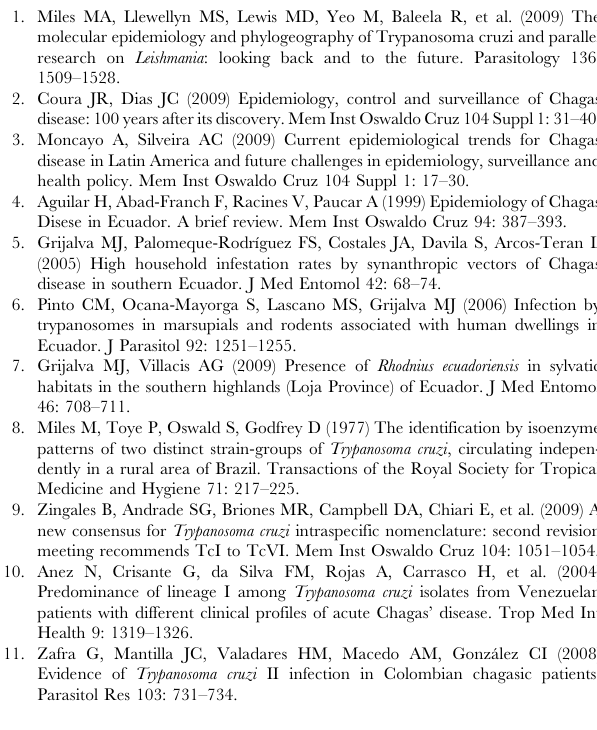
Table S3 Allele sizes (in base pairs) from 10 loci analyzed (fluorescent dye) from 81 T. cruzi isolates from Loja Province,